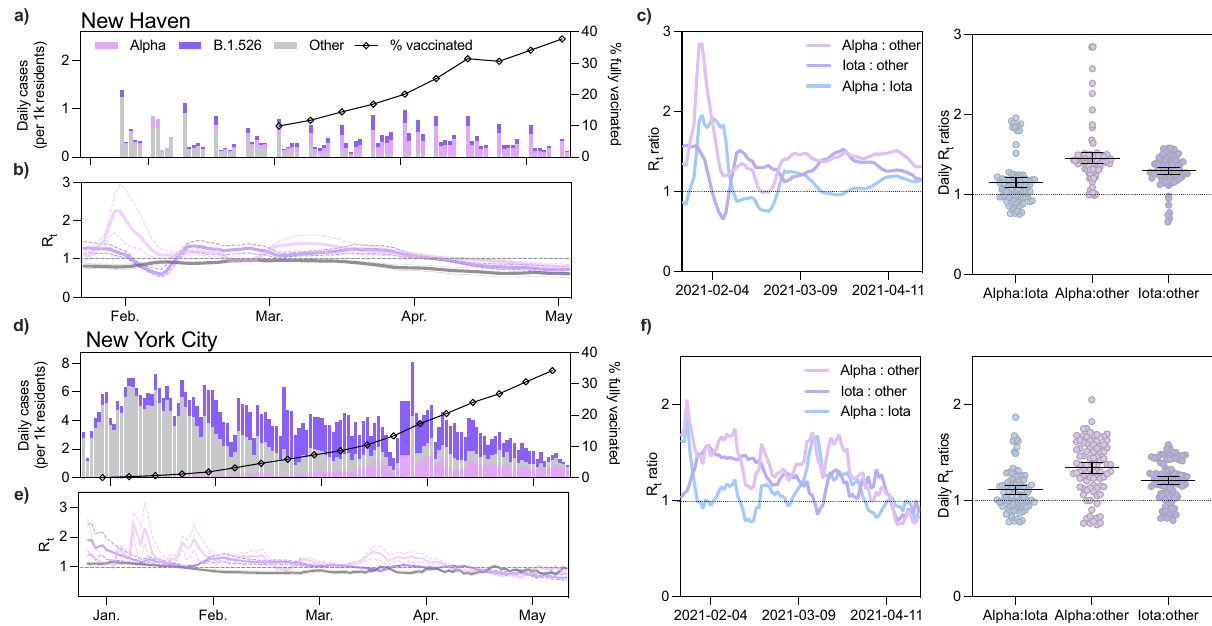
Fig. 2 Alpha and Iota had a larger effective reproduction number (R t ) than other circulating lineages in the fi rst half of 2021. a , d Daily incidence and full vaccination rates (2 weeks post last dose) of Alpha, Iota, and other circulating lineages in New Haven County ( a ) and New York City ( d ). Estimated daily infections were assigned to one of three lineage categories ( ‘ Alpha ’ , ‘ Iota ’ , and ‘ other ’ ) according to the 7-day rolling average of variant frequency among sequenced cases. ‘ Iota ’ includes the sublineages B.1.526, B.1.526.1, and B.1.526.2. b , e Time-varying effective reproduction numbers (R t ) were calculated using the R package EpiEstim. An R t value above 1 indicates that an infected individual will, on average, infect more than 1 additional person. We assumed a serial interval of mean 5.2 days and standard deviation of 4 days for all lineages. 0.025 and 0.975 quantiles are shown as dotted lines. c , f Ratios of estimated R t between January 24 and April 24, 2021. The mean and 95% CI for the scatter plots are shown in